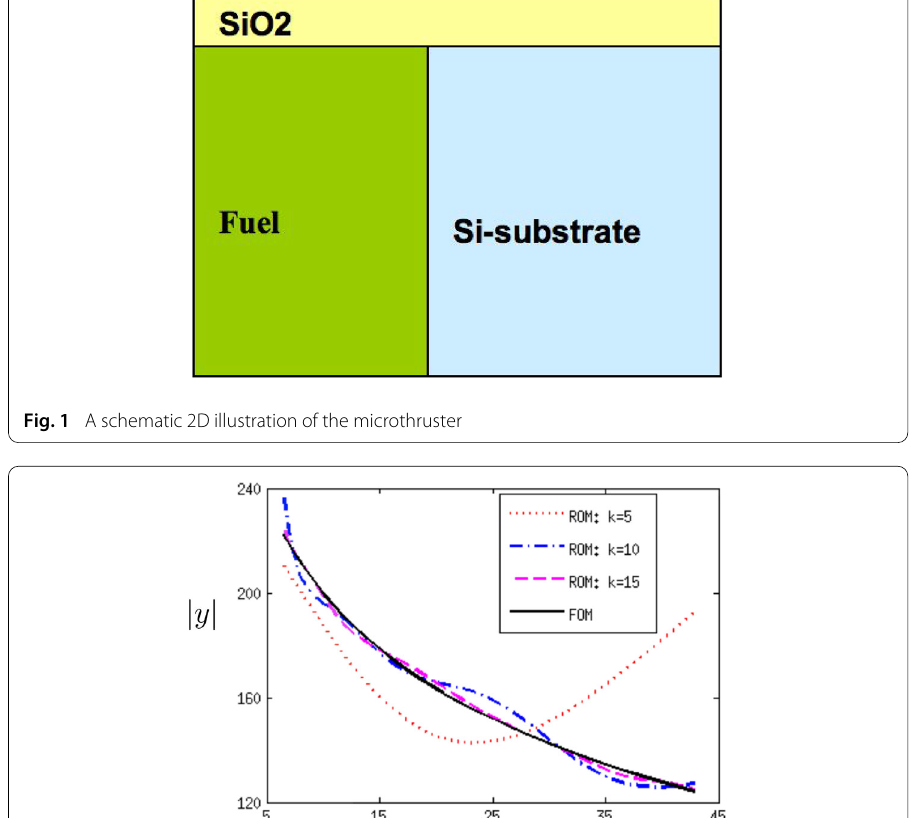
PMOR on the microthruster